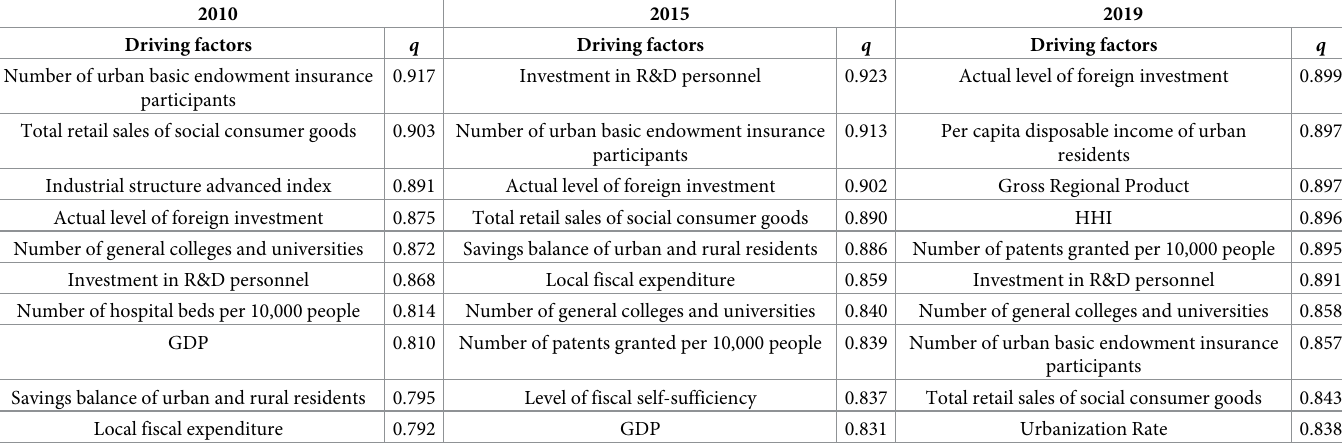
Table 6. Results of driving factors of the coupling coordination degree between economic resilience and high-quality economic